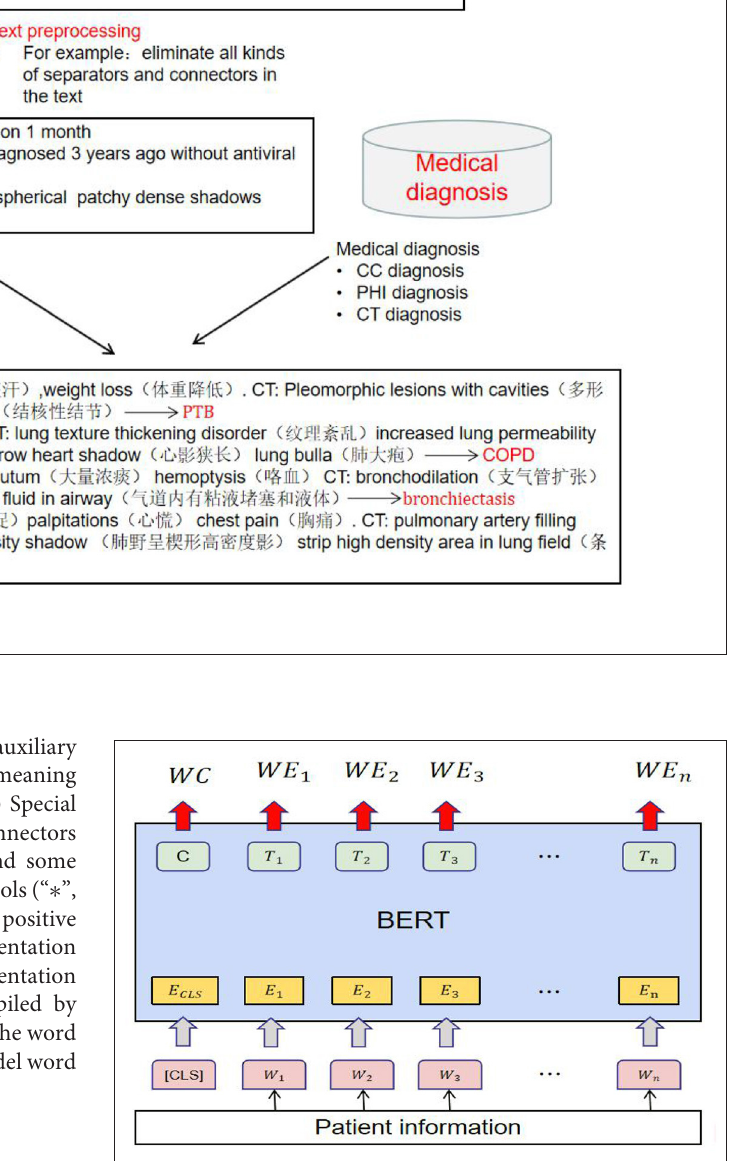
FIGURE 3 | BERT model Generate word vectors of